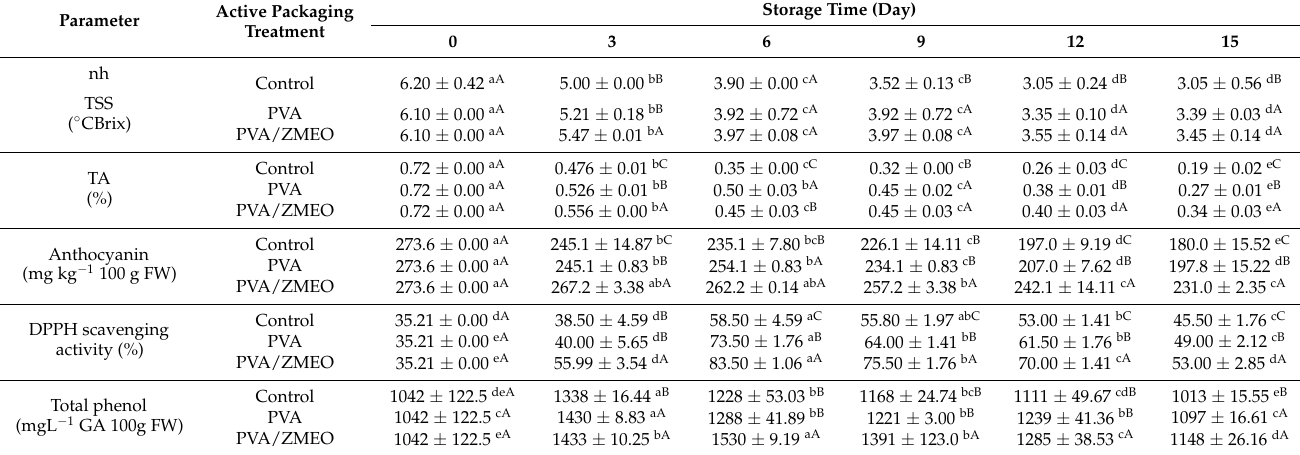
Table 4. Effect of active packaging using PVA fiber (PVA) and PVA fiber loaded with Zataria Multifora essential oil (PVA/ZMEO), and storage time on chemical traits of strawberry fruits stored at 4 ◦ C for 15